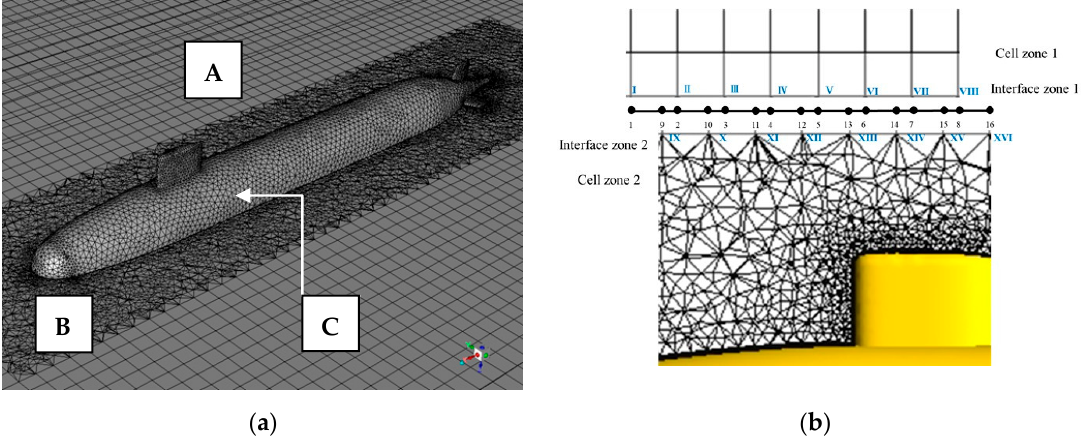
Figure 4. The mesh configuration of ( a ) the multi-zone fluid domain, and ( b ) the interface, respectively.